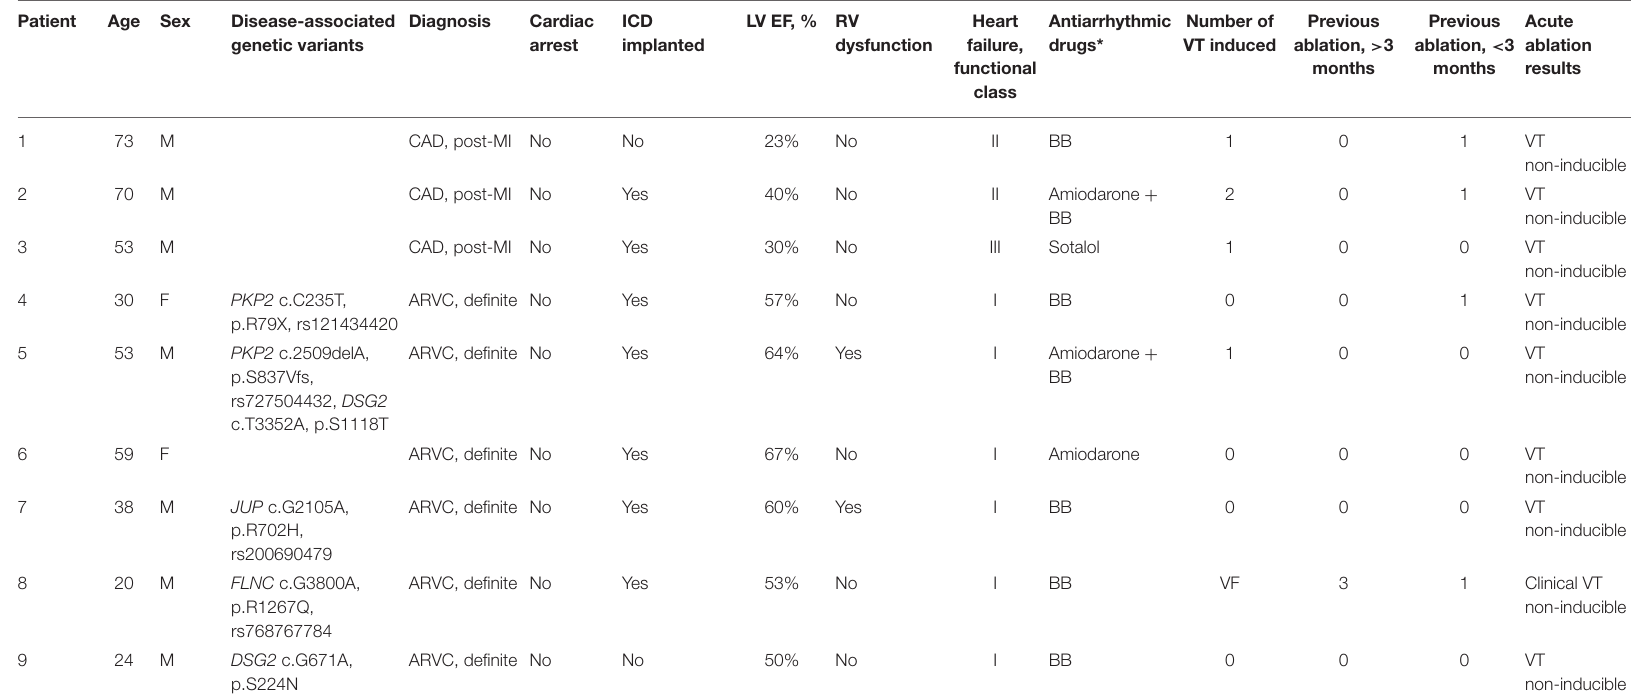
TABLE 1 | Patient demographics and clinical characteristics.